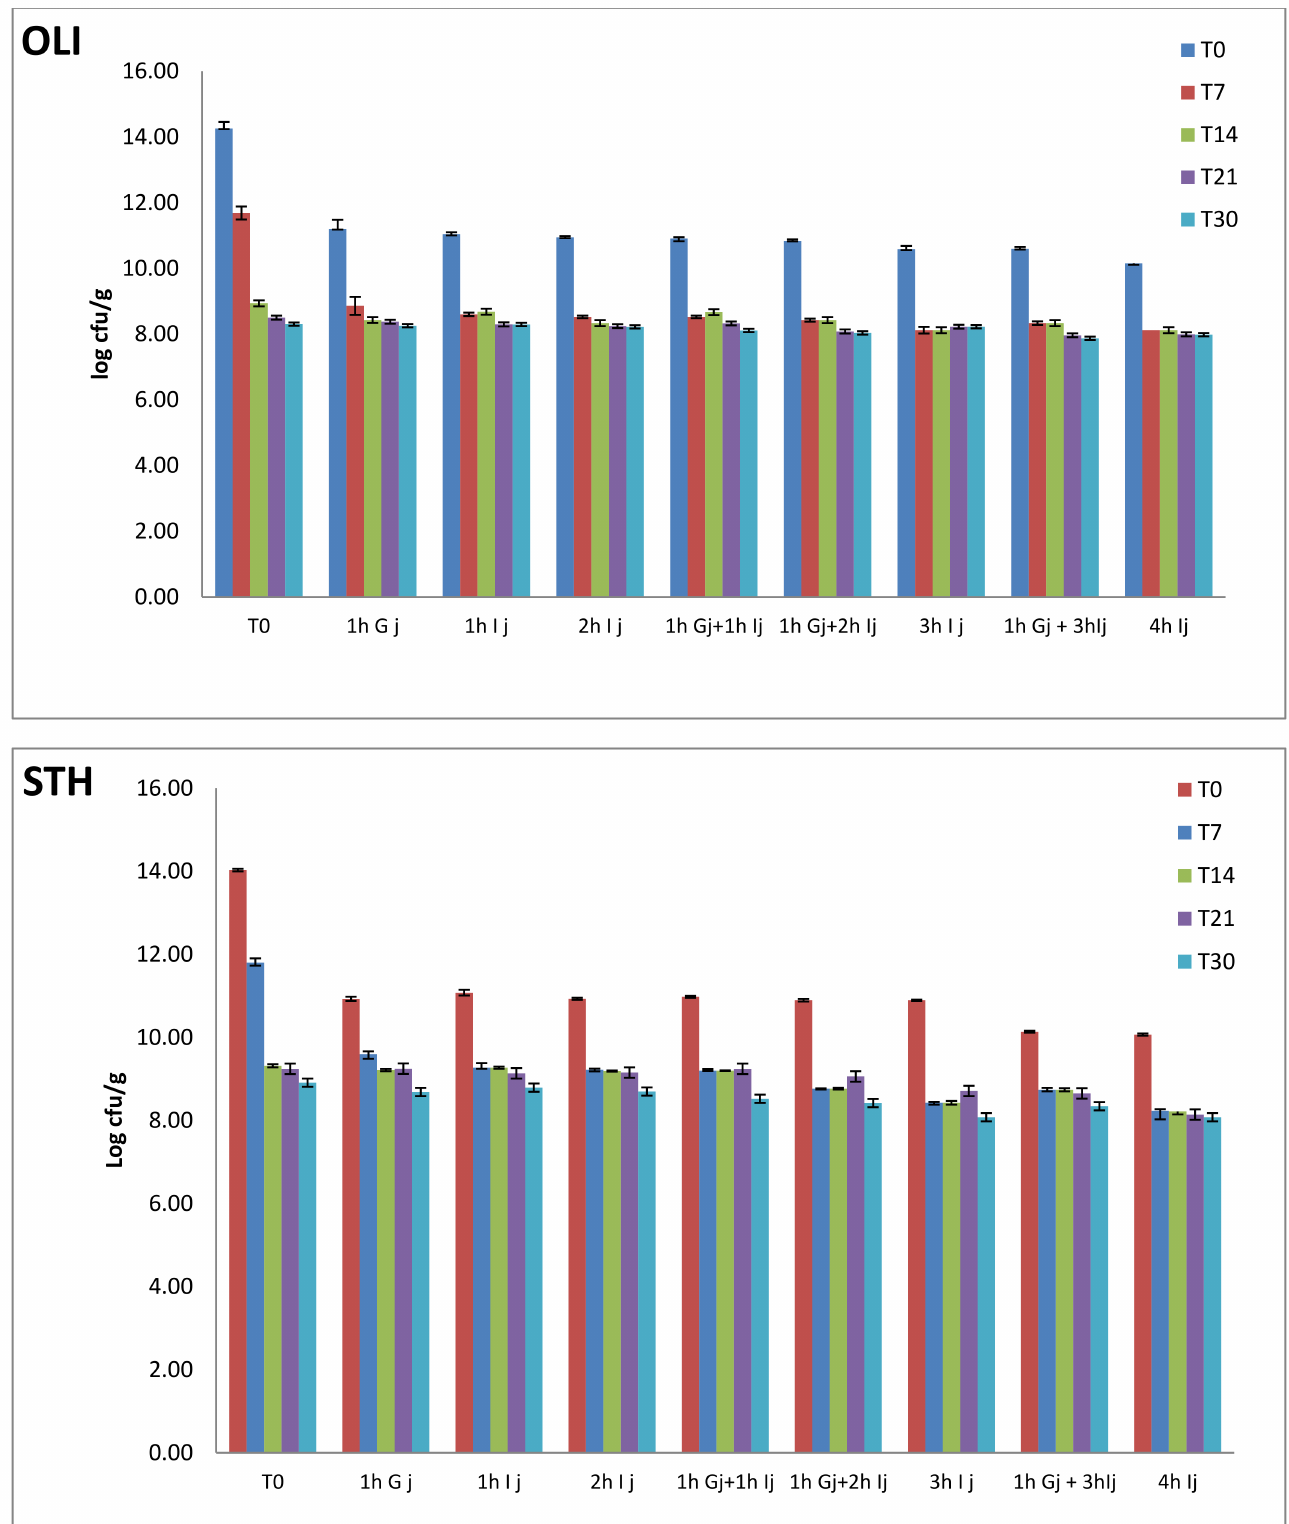
Figure 5. Cell viability in simulated gastrointestinal juices for microcapsules. 1 h gj—viability in microcapsules that stayed for one hour in the simulated gastric juice at 37 ◦ C, 1 h Ij—viability in microcapsules that stayed for one hour in the simulated intestinal juice at 37 ◦ C, 1 h gj + 1 h Ij (2 h Ij; 3H Ij)—viability in microcapsules that stayed one hour (two, respectively three hours) in the gastric juice then one hour in the intestinal juice at 37 ◦ C. T0, T7, T14, T21, T30—storage moments (